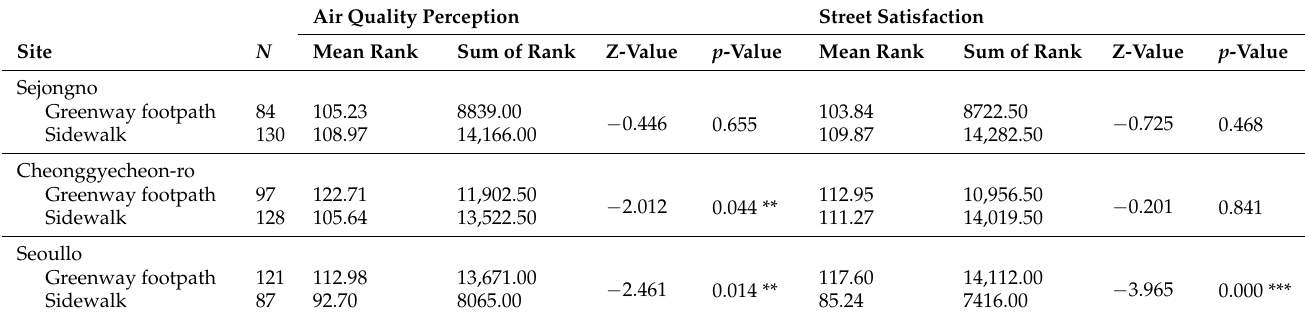
Table 4. Air quality perception of the sidewalk and greenway footpath for pedestrians (Mann–Whitney